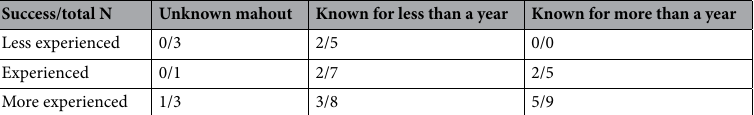
Table 1. Number of successes of elephants at the novel surface task for the different dyads for each crossed category.